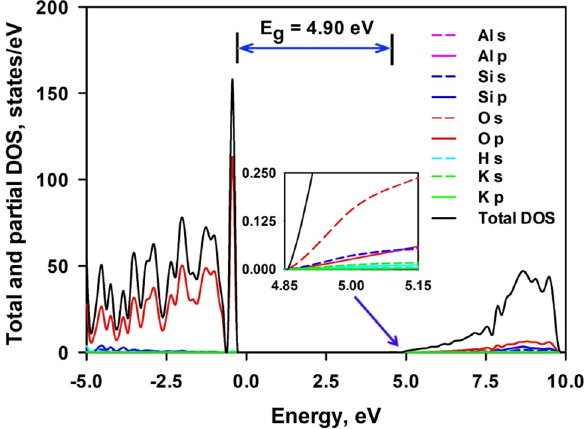
Figure 3. Total and projected density of electronic states of bulk mica. The inset is a magnificence of the CBM region. The energy is given relative to the Fermi energy set at zero.